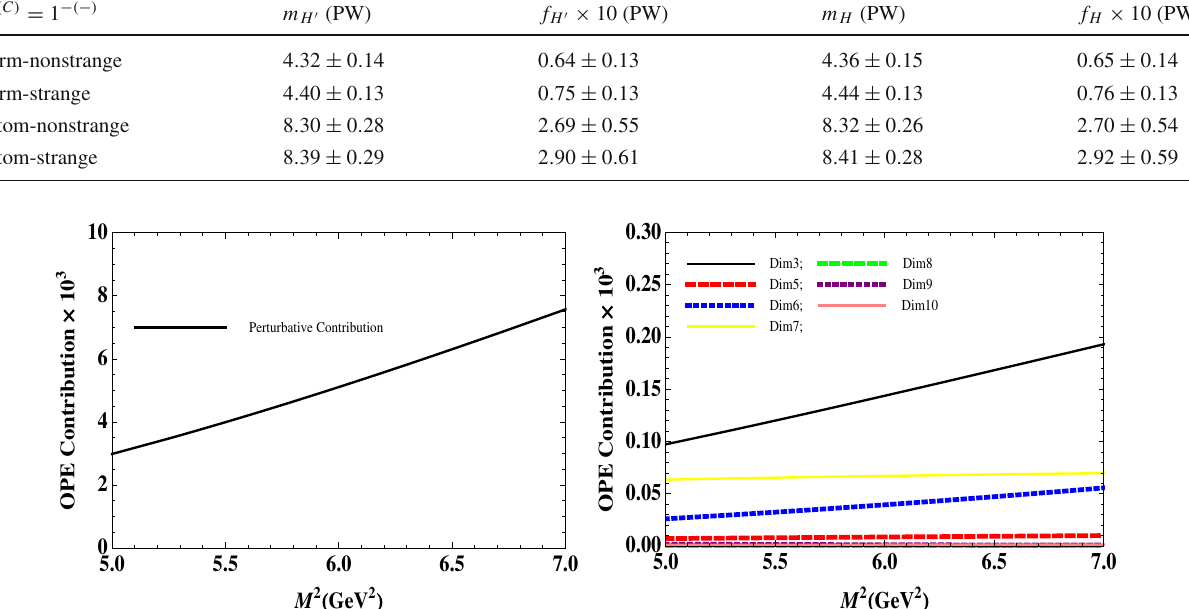
Fig. 3 The perturbative and non-perturbative contributions in units of GeV 8 to the sum rule of the charm-nonstrange hybrid meson with the quantum numbers J P ( C ) = 1 − ( − ) : Perturbative contribution (left panel) and absolute values of different non-perturbative contributions (right panel) as functions of M 2 at average s